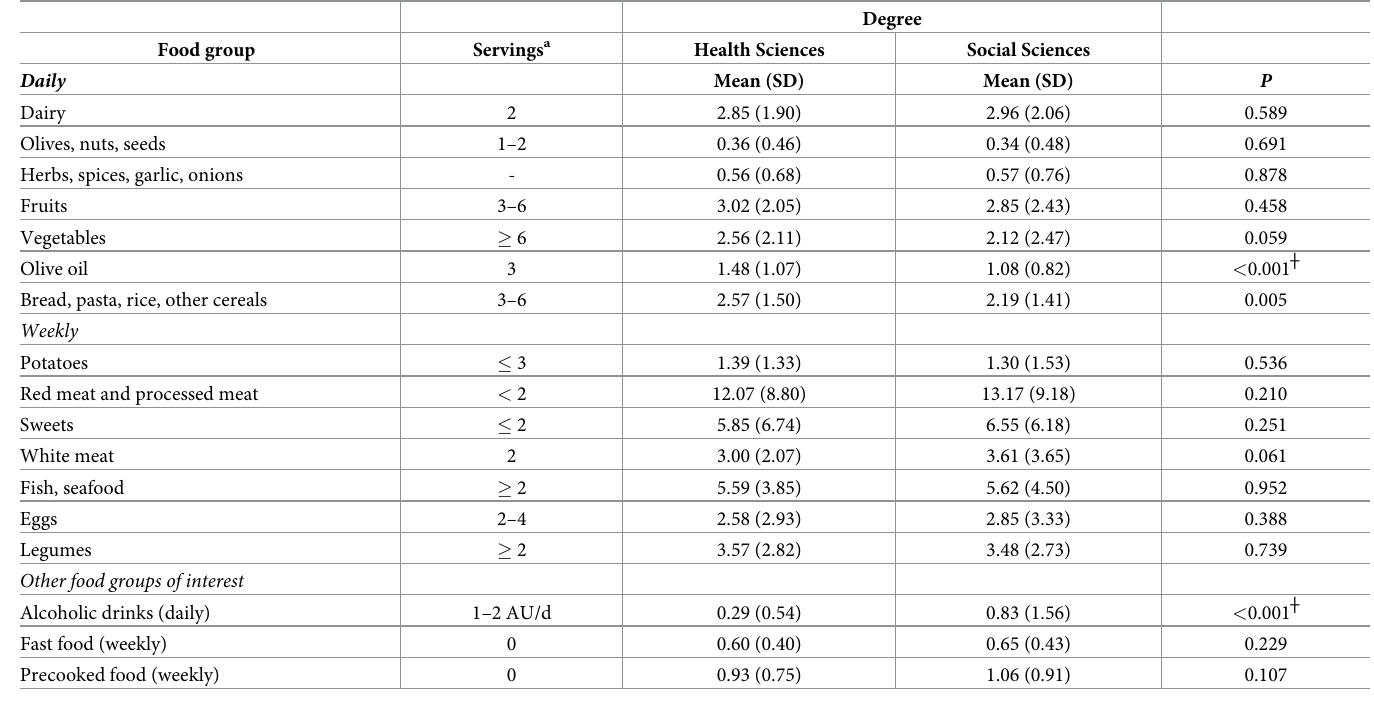
Table 6. Mean differences in food group consumption by degree course ( n =